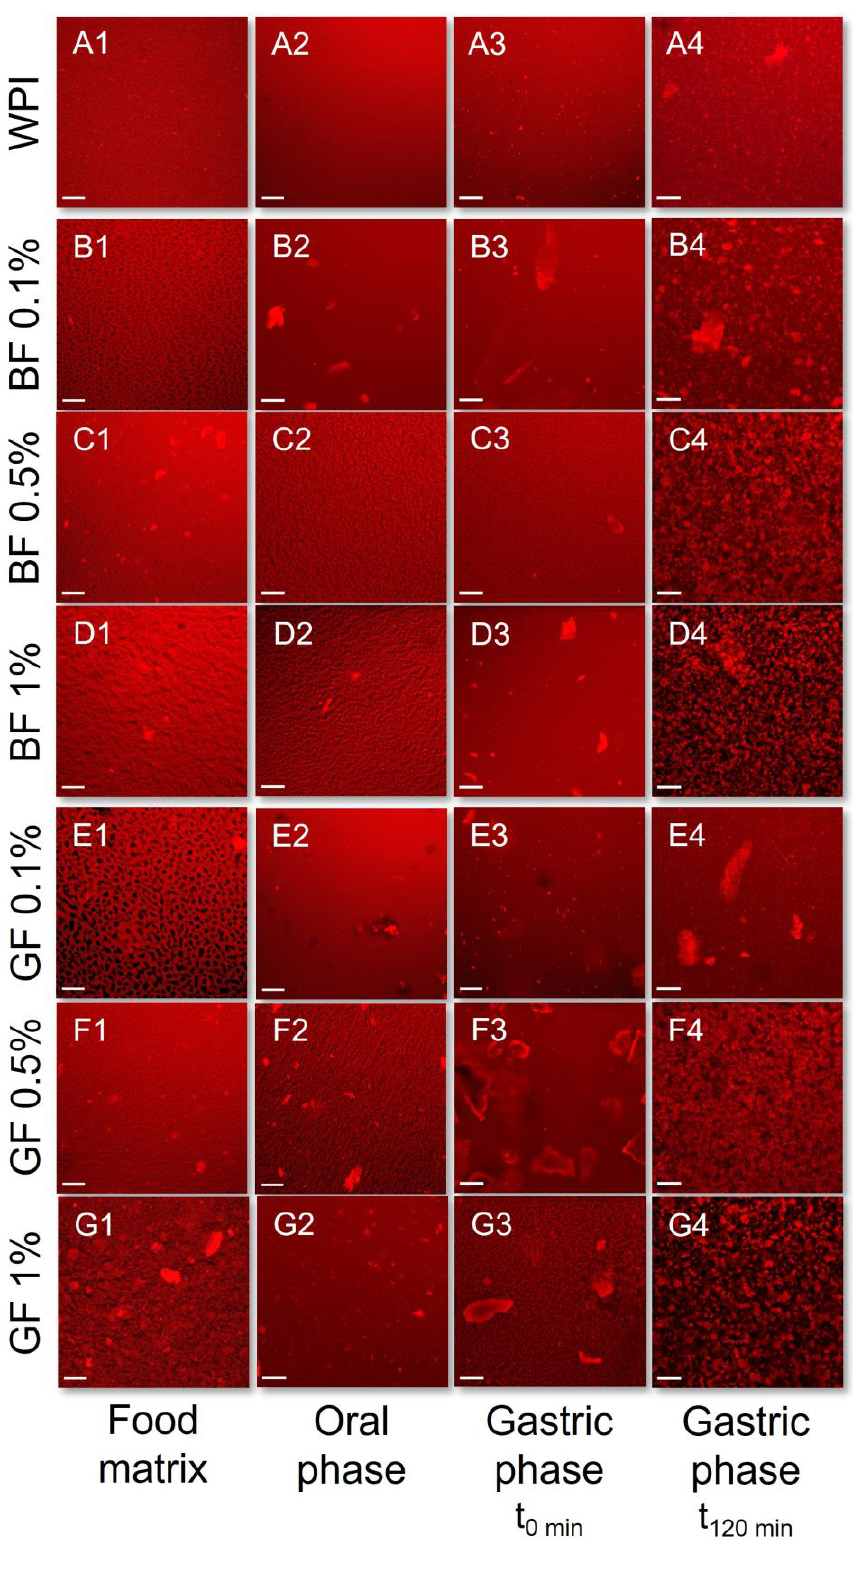
Figure 2. Impact of flaxseed gums on the in vitro oro-gastric induced colloidal changes of the WPI- based food models adopting the INFOGEST 2.0 in vitro digestion model. 1 : Food matrix, 2 : Oral phase; 3 : gastric (start); 4 : gastric (end); A : WPI only; B , C , D : WPI + BF; E , F , G : WPI + GF. Scale bar = 100 μm.